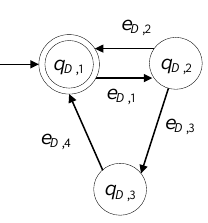
Figure 4. State diagram of